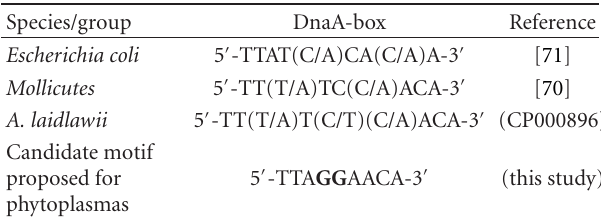
Table 2: Consensus of the DnaA-box